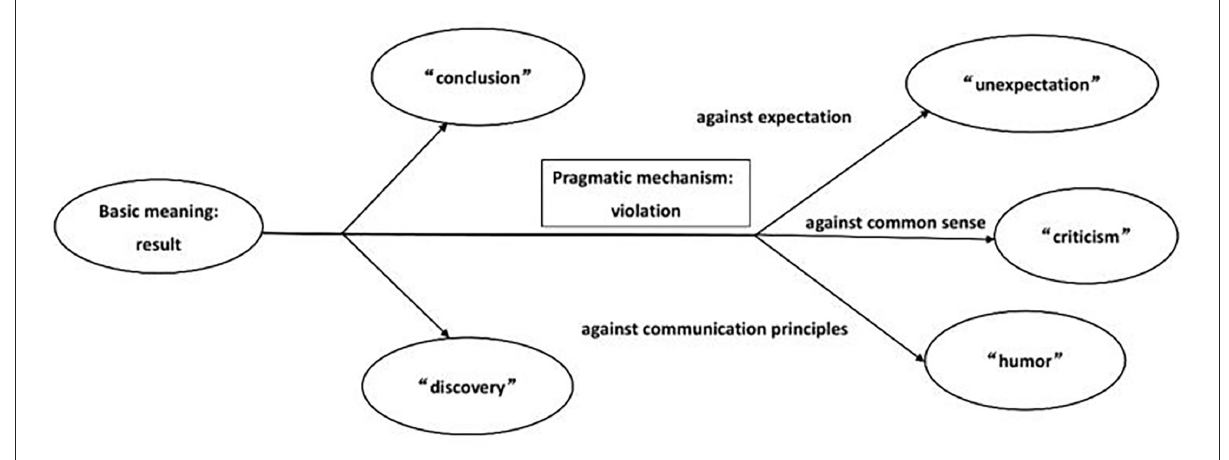
FIGURE5 The meanings and pragmatic functions of “nao le bantian(guiqi).”